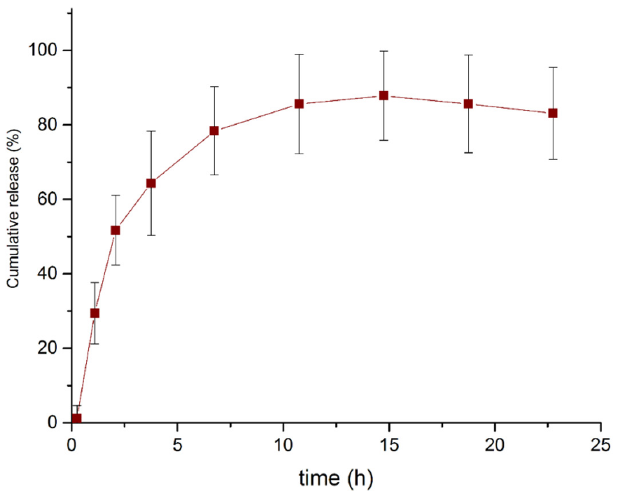
Figure 6. Cumulative release kinetic of curcumin from composite microspheres in PBS at a 90:10 (PHBV/MBGN) ratio in PBS.